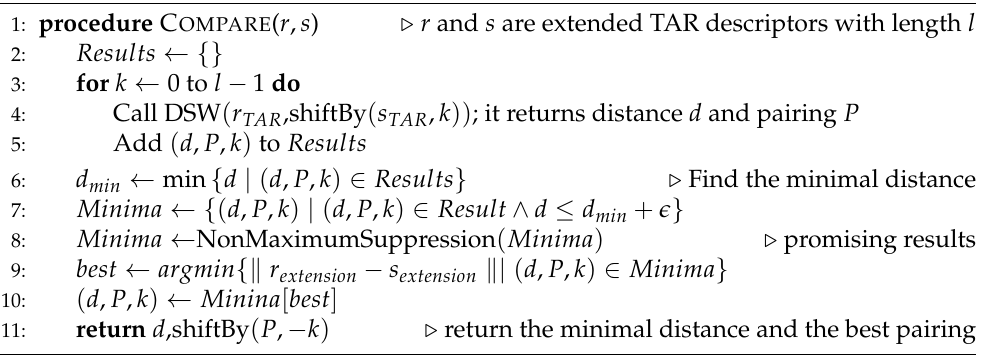
Algorithm 4 Shape comparison